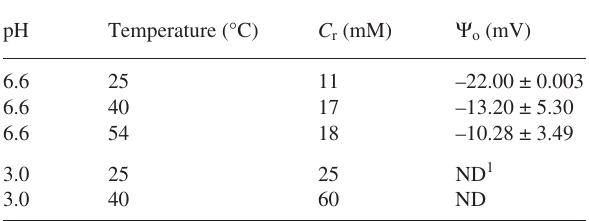
Table 2. Effects of pH and temperature on the threshold Ca 2+ concen- tration ( C r ) for PLFE vesicle aggregation and on the surface potential ( Ψ o ) of PLFE vesicles (117 nm in diameter) prior to